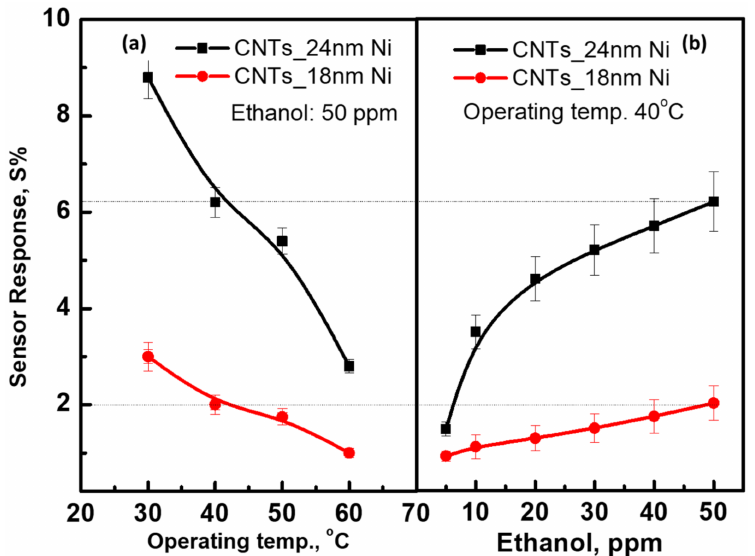
Figure 7. The sensor response of the prepared device is a function of; ( a ) operating temperatures at 50 ppm and ( b ) gas concentration at an operating temperature of 40 ◦ C.